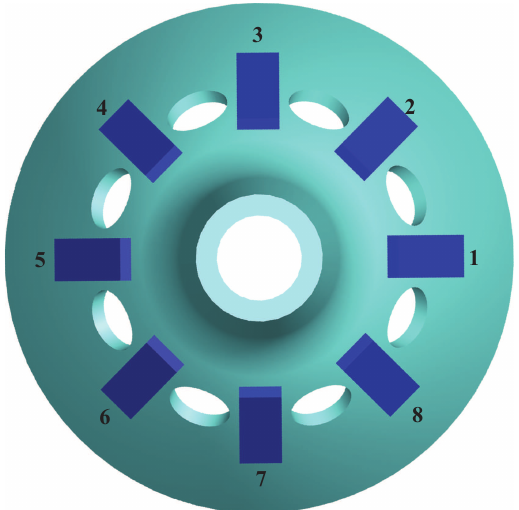
Figure 4. Schematic of mount